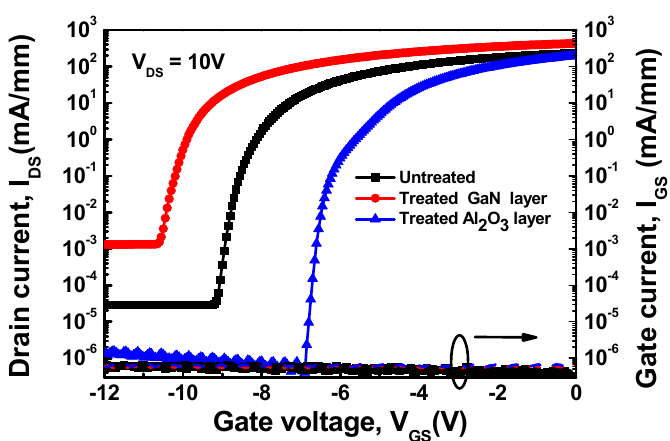
Figure 5. Transfer characteristics of AlGaN/GaN MOS-HEMT: untreated, with a treated GaN layer, and with a treated Al 2 O 3 layer.